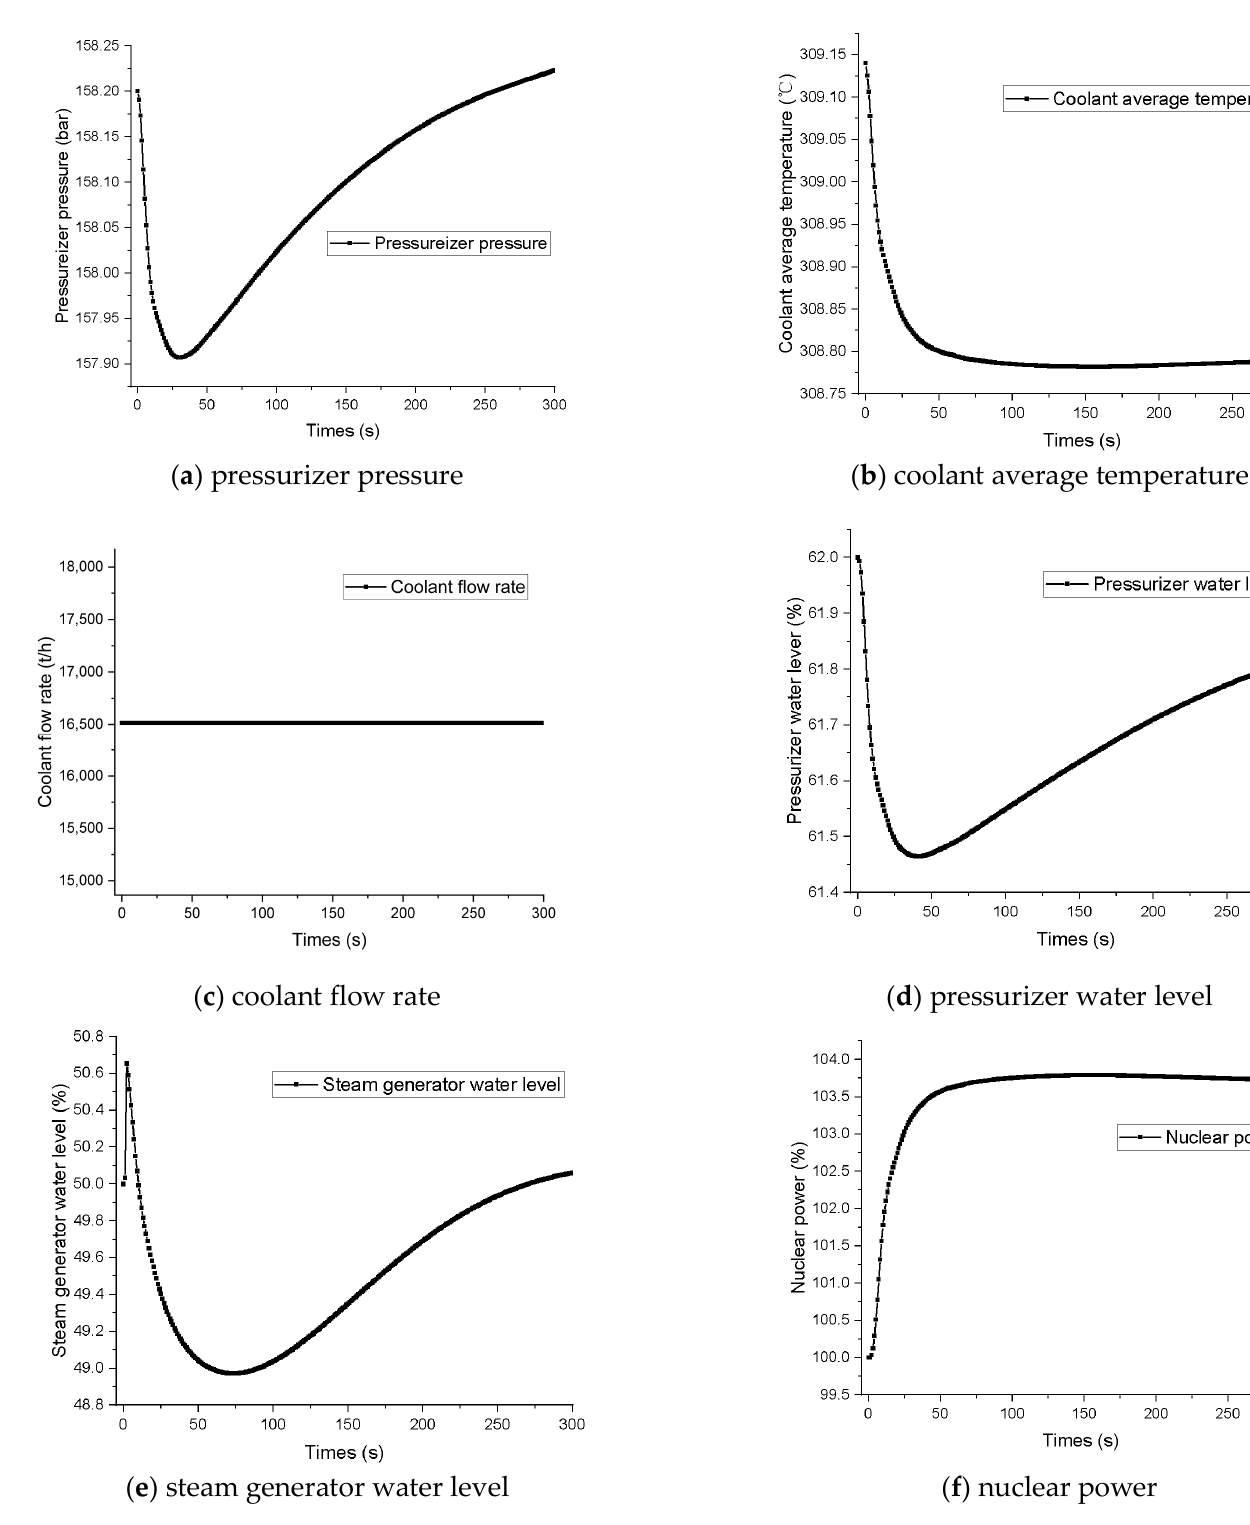
Figure 9. Operating trend of containment steam pipe rupture.